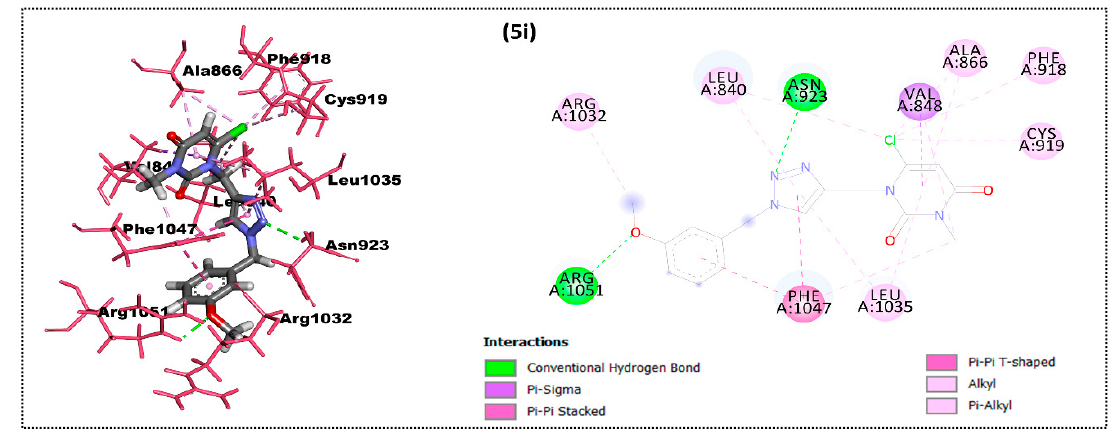
Figure 7. Docking interactions (3D & 2D) of 5i with the receptor protein, VEGFR-2 transferase. Critical amino acid residues are shown in the stick model and pink colour.